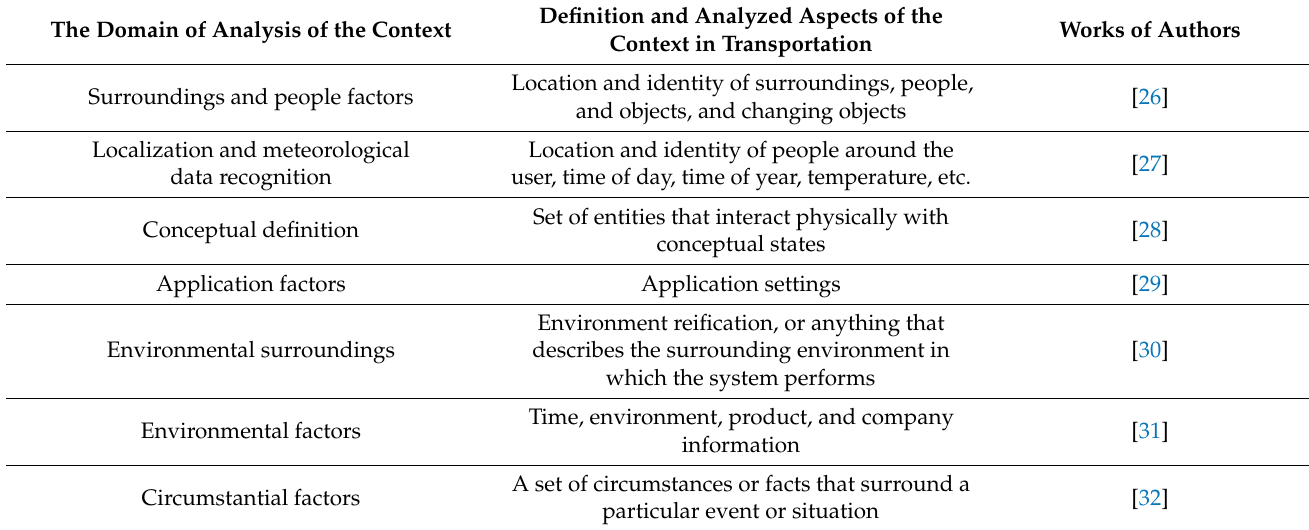
Table 1. Review of the analyzed aspects of the contextual information related to